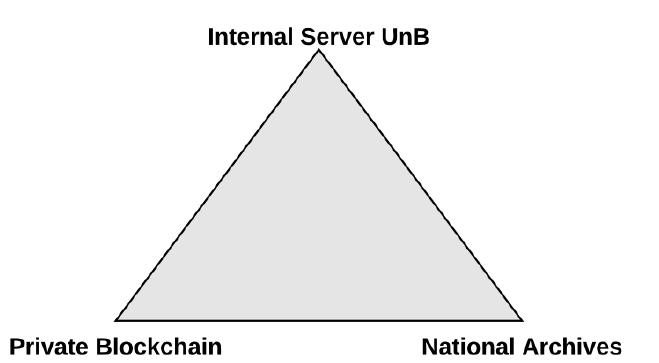
Figure 13. Verification servers for validating the signed degree